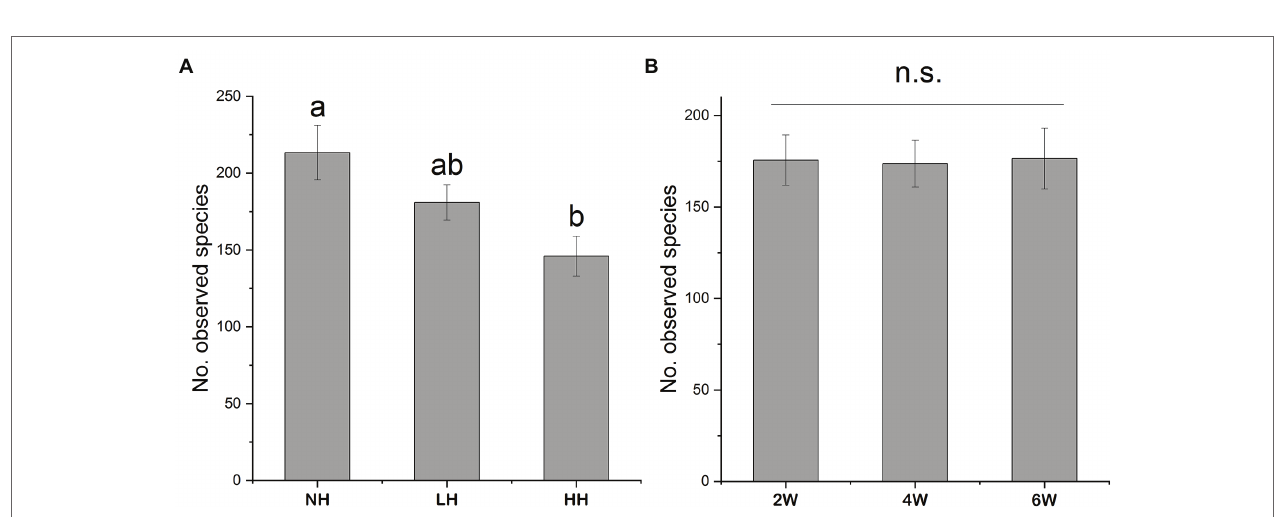
FIGURE 2 | Number of observed rhizosphere fungal operational taxonomic units (OTUs) in rhizosphere soils as affected by different herbivory intensities (A) and time since herbivore removal (B) . Different letters indicate statistically significant differences between treatments at p < 0.05. n.s., non-significant.